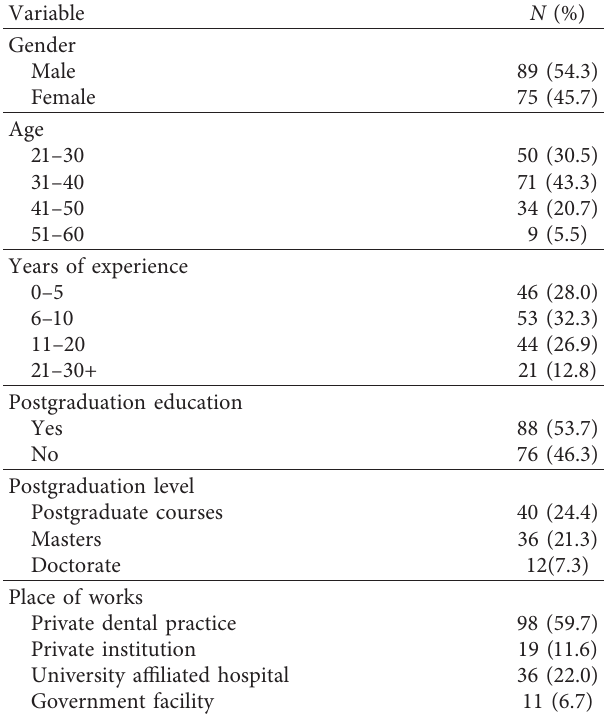
Table 1: Demographics and characteristics of